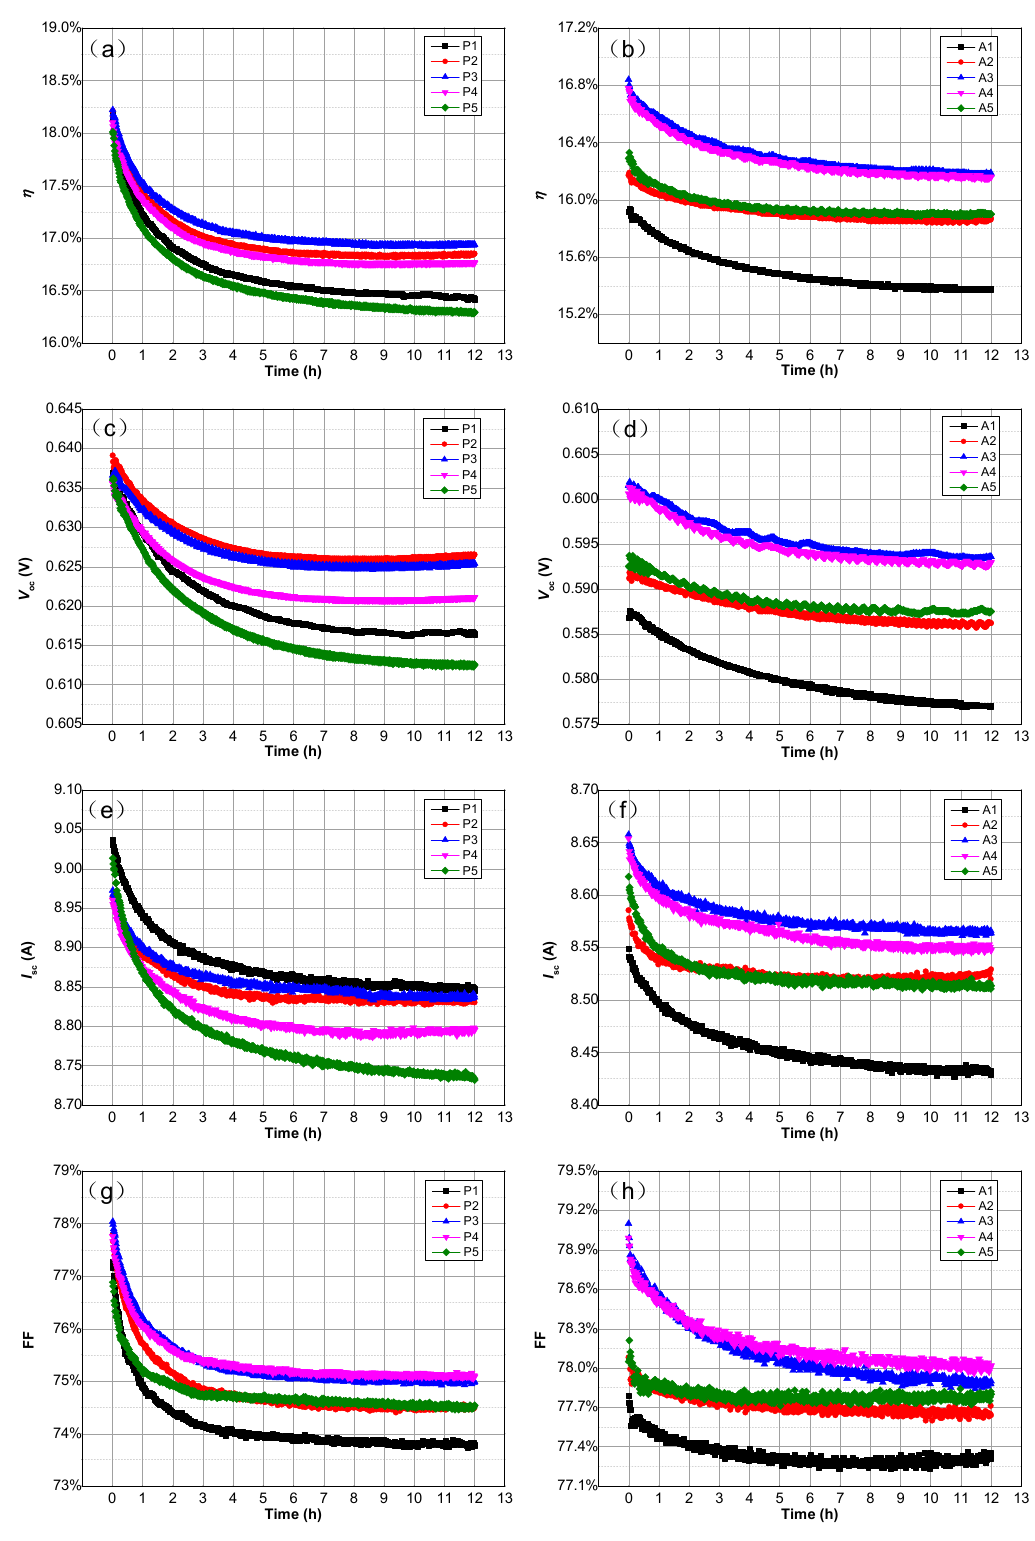
Figure 1. In situ variations of η , V oc , I sc and FF of five groups of PERC ( left column) and Al-BSF cells ( right column) with process time during the first LID (1 sun, 45 ℃ , 12 h). ( a ) η of PERC cells; ( b ) η of Al-BSF cells; ( c ) V oc of PERC cells; ( d ) V oc of Al-BSF cells; ( e ) I sc of PERC cells; ( f ) I sc of Al-BSF cells; ( g ) FF of PERC cells; ( h ) FF of Al-BSF cells.